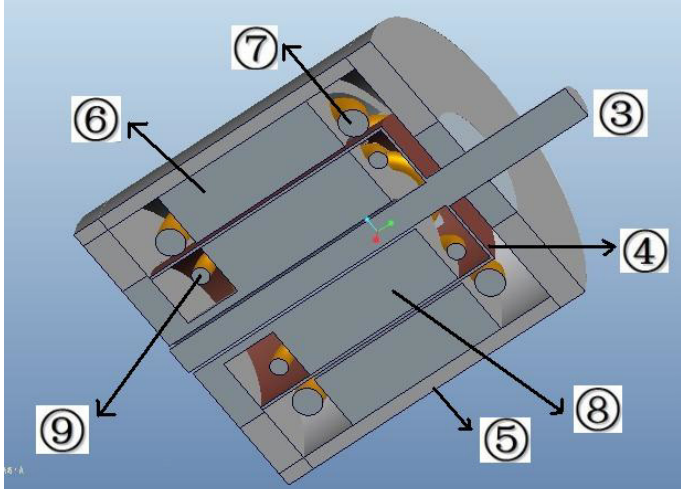
Figure 2. 3D sectional view of the sensor.